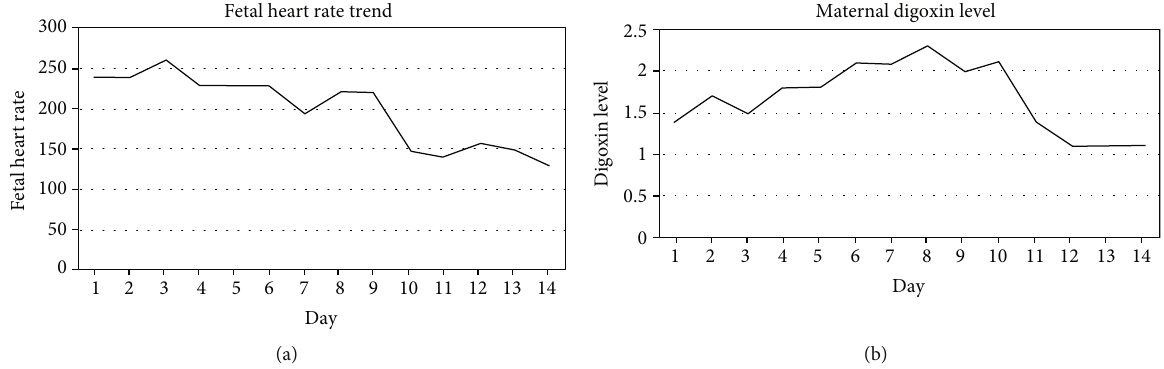
Figure 1: Fetal intramuscular injection of digoxin occurred on Day 9, and fetal heart rate normalized on Day 10 at 150bpm (a). Maternal digoxin level. Day 1 represents maternal digoxin levels prior to the third dose of oral digoxin, dosed at eight-hour intervals. Levels returned to the therapeutic range on Day 11 (b).